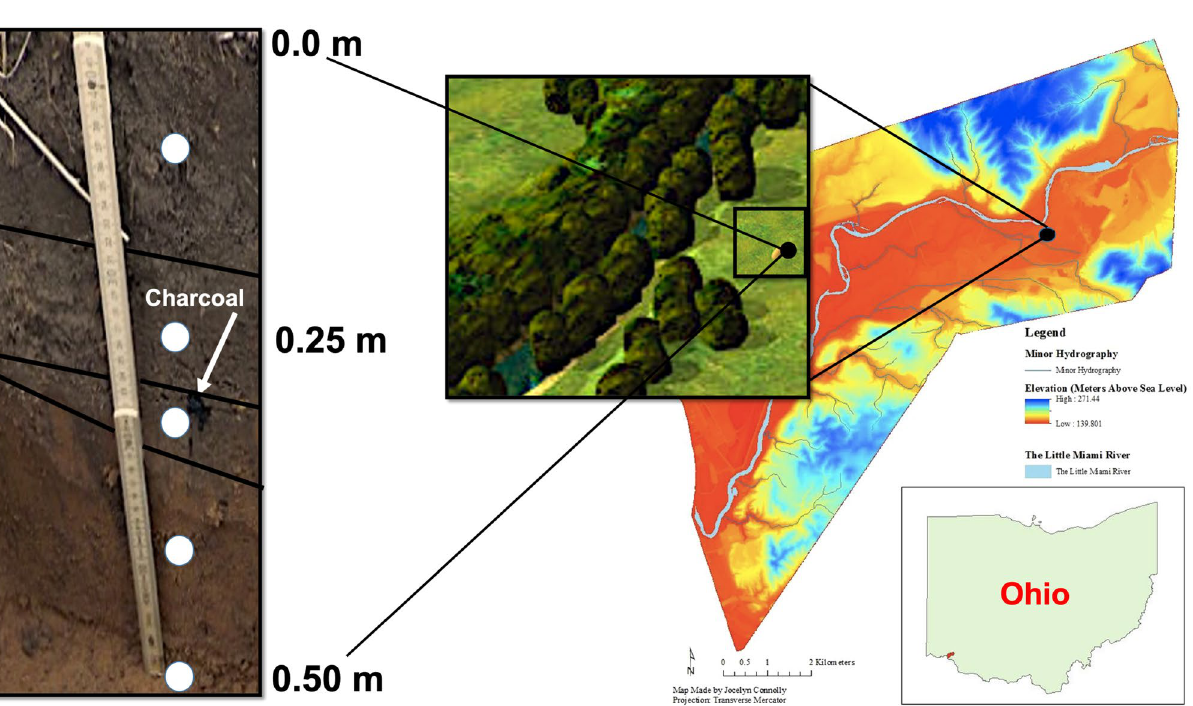
Figure 3. The location, stratigraphy, and sediment sample sites (white circles) of the Moundview village and mound site, Hamilton County, Ohio. Kenneth Barnett Tankersley used Microsoft PowerPoint for Mac Version 16.41 (www. micro soft. com) to create this figure. The GIS map was produced in ESRI ArcGIS 10.3.1 software (www. esri.